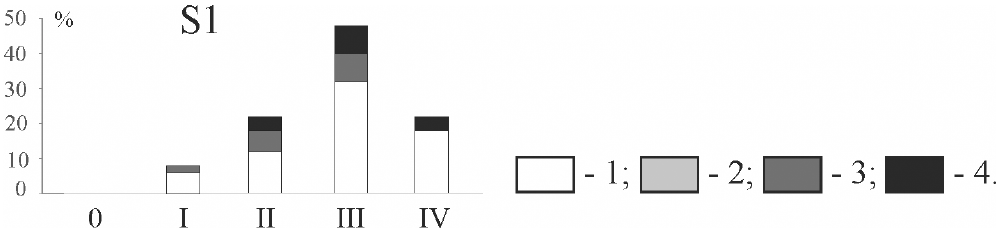
Figure A5. Distribution of quartz sand grains from section NS-22 by roundness and dullness. (1) Glossy; (2) quarter-matte; (3) half-matte; (4) matte; 0, I, II, III and IV are grades of roundness according to Khabakov